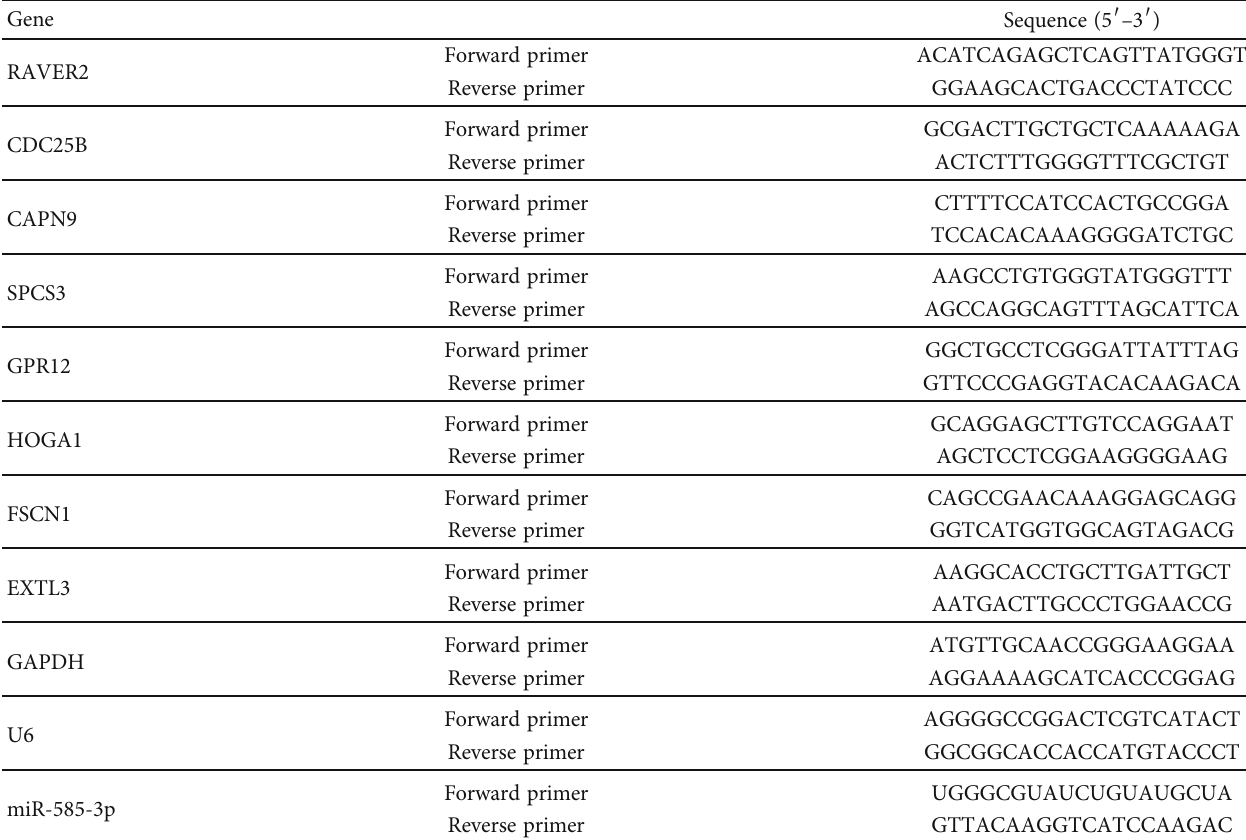
Table 1: Primer sequence